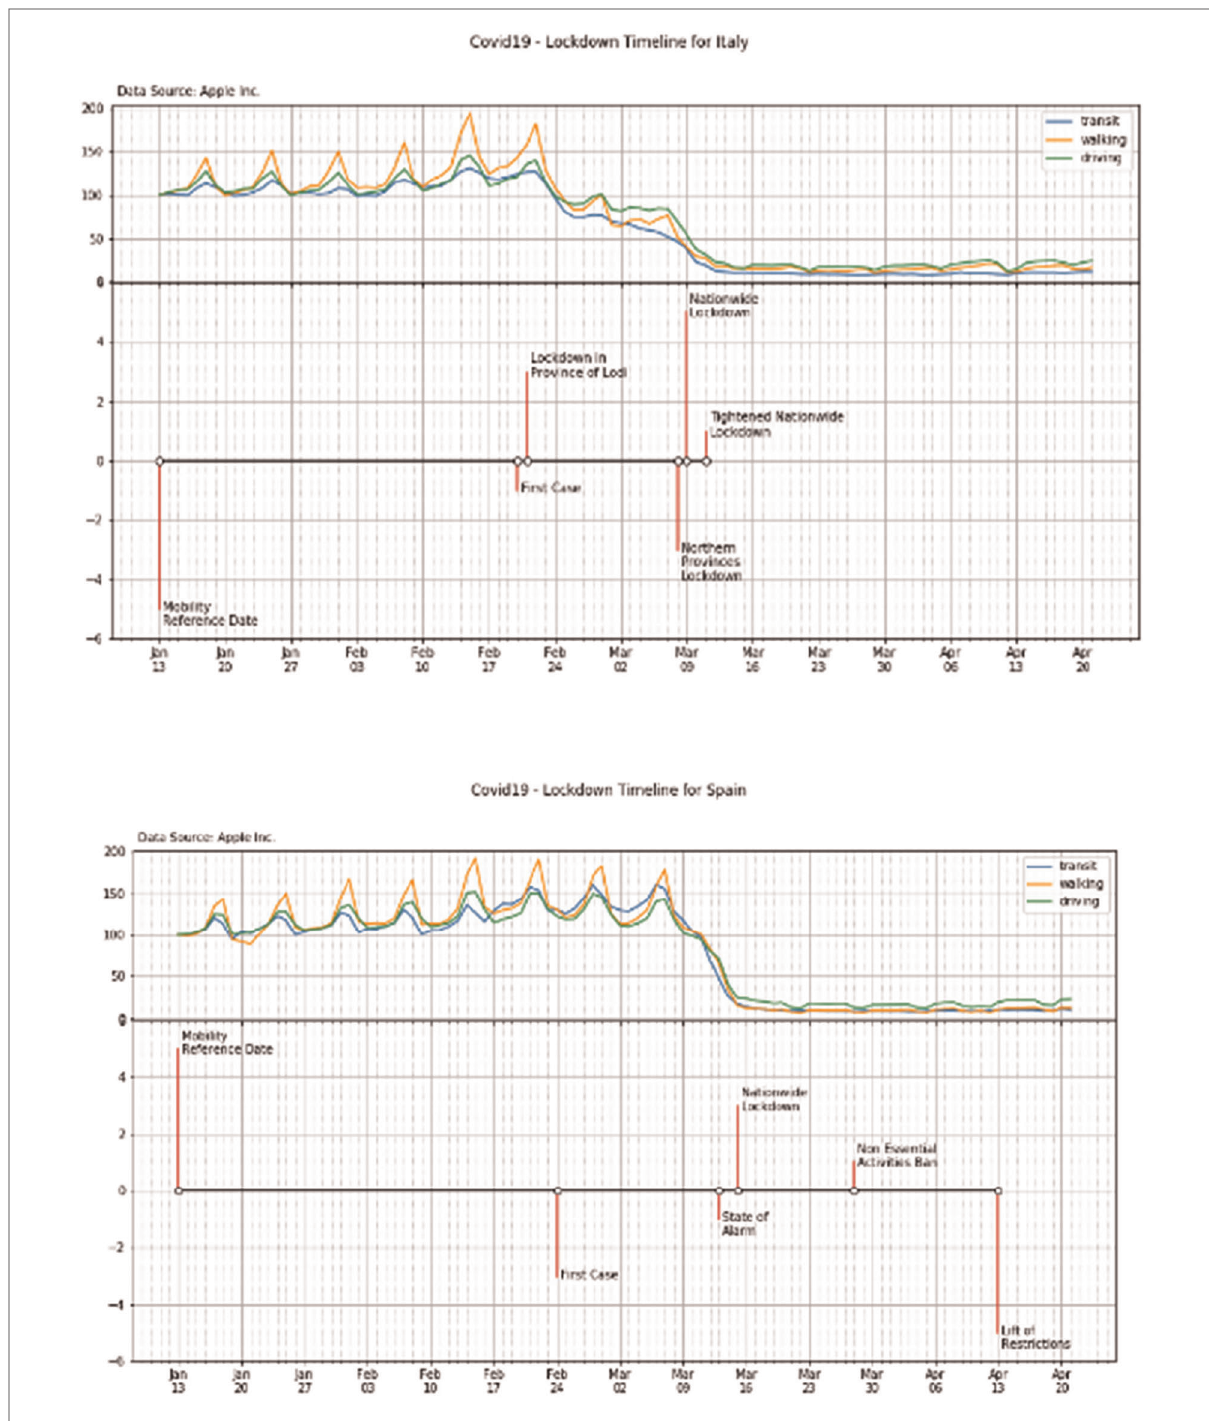
FIGURE 9 Timeline of the national mobility of Italy and Spain on the top and bottom panels,